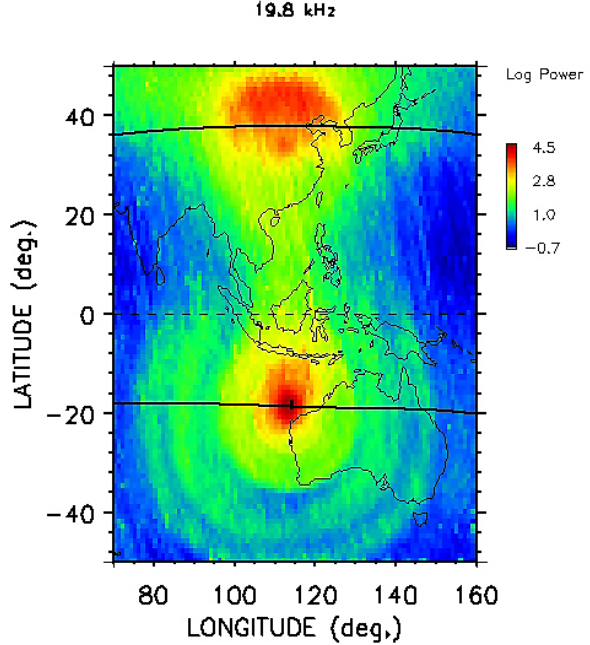
Fig. 2. Distribution of the electric power of the NWC transmitter at Demeter altitudes. The power of the NWC transmitter is 10 4 higher than that measured at 13:20UT on 13 August 2005 in the frequency range 10–19kHz (see Fig. 1). The black curves indicate the L = 1 . 4 contours at the satellite